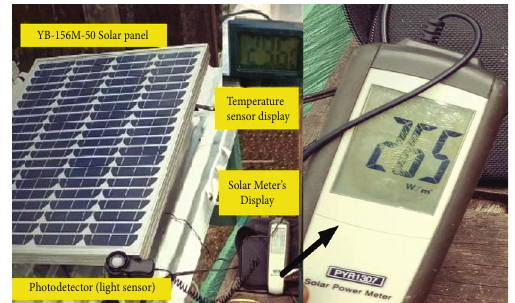
Figure 22: Experimental setup for real-time data